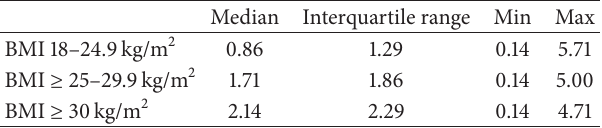
Table 3: Shape concern subscale scores by BMI classification at